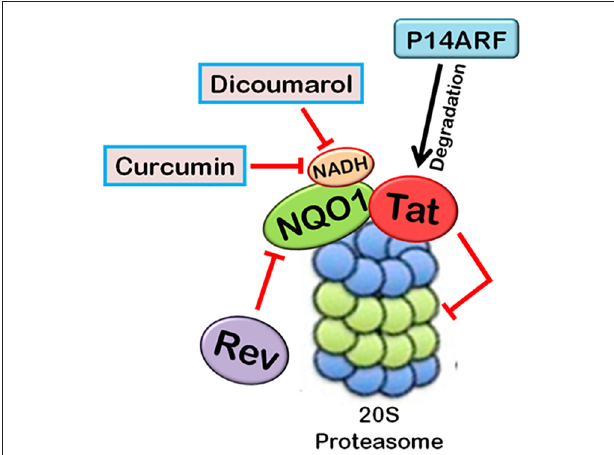
FIGURE 5 | Interplay between HIV-1 proteins and 20S proteasome machinery. 20S proteasomal pathways play a significant role in HIV-1 replication. HIV-1 Tat, being an unstructured protein, is degraded by 20S proteasome. NQO1 inhibits the degradation and stabilizes the expression of Tat in the presence of NADH. HIV-1 Rev downregulates NQO1 and induces the degradation of Tat by 20S proteasome. Dicoumarol and Curcumin are the chemical inhibitors of NQO1 activity. They compete with NADH to bind NQO1, thereby inhibiting its action. P14ARF also induces 20S proteasomal degradation of Tat independent of ubiquitin. HIV-1 Tat, in turn, inhibits the activity of 20S